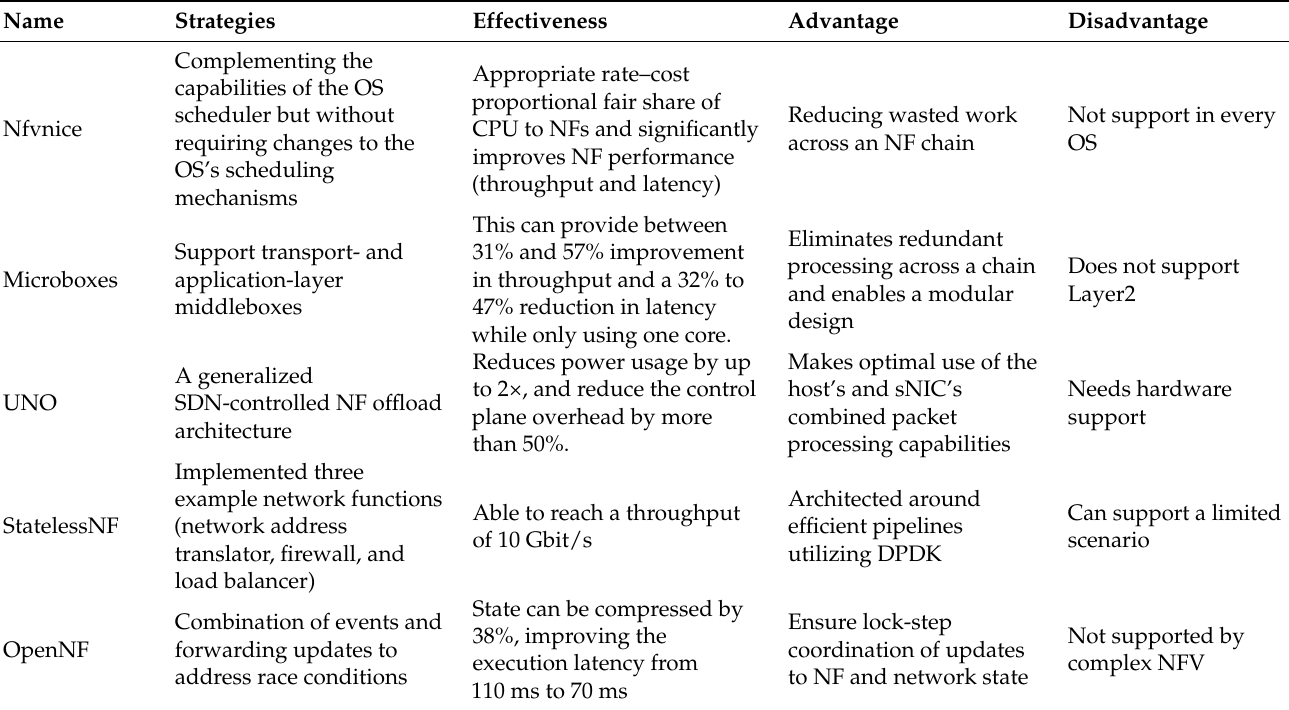
Table 5. The acceleration solutions in